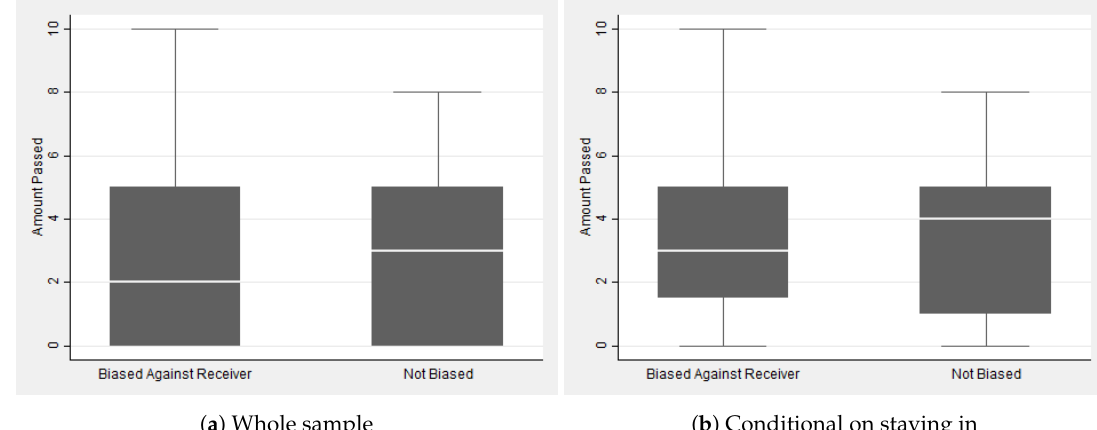
Figure 4. Sharing when the dictator is